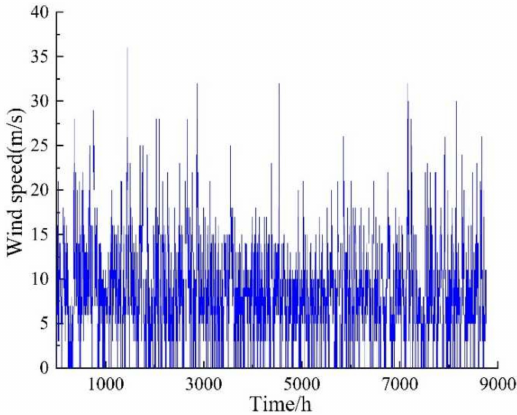
Figure 7. Full year wind speed forecast curve.